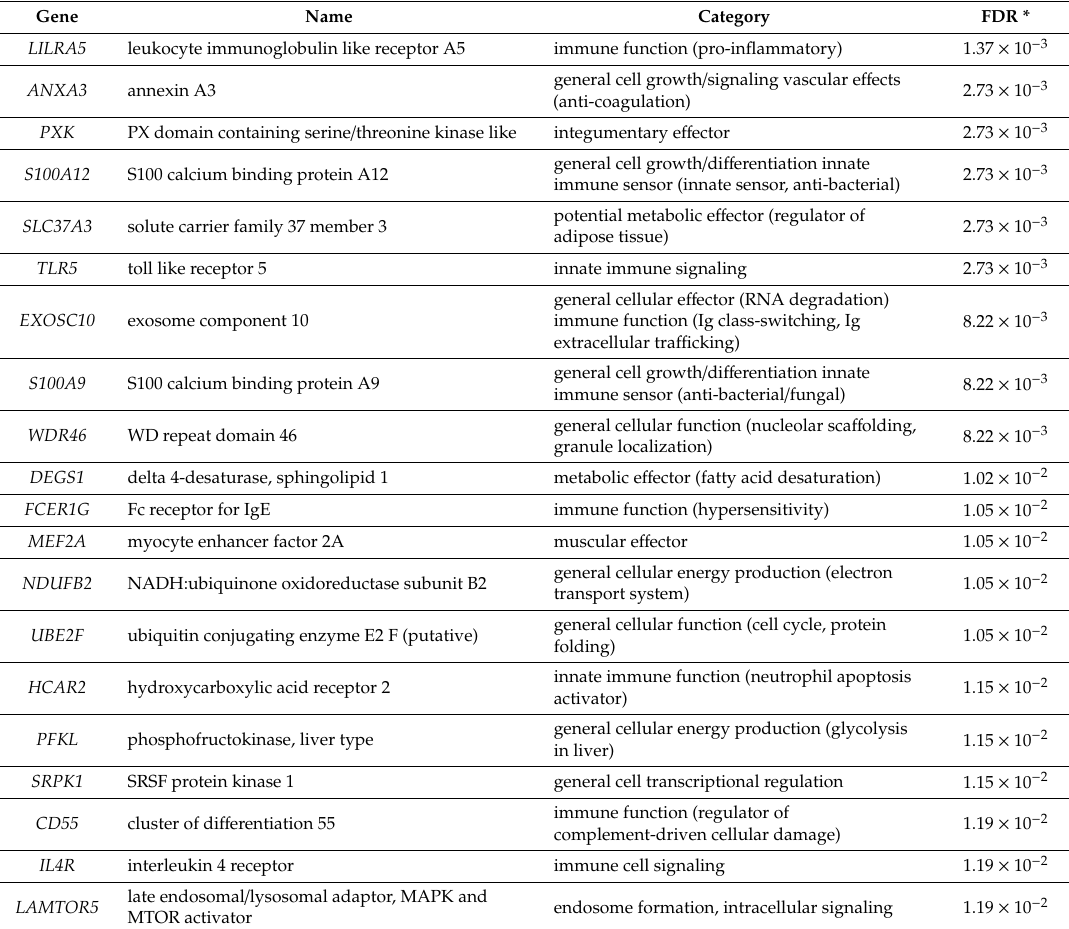
Table 2. Top 20 Di ff erentially Expressed Genes Associated with